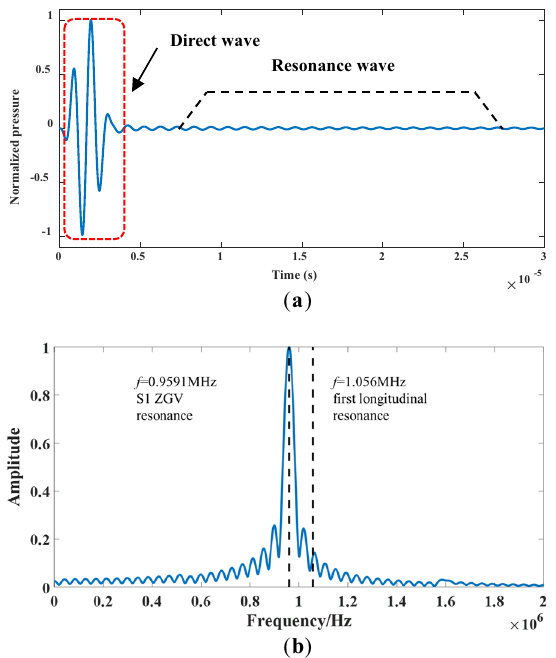
Figure 9 Typical received results: ( a ) A-scan waveforms and ( b ) frequency spectrum of resonance wave